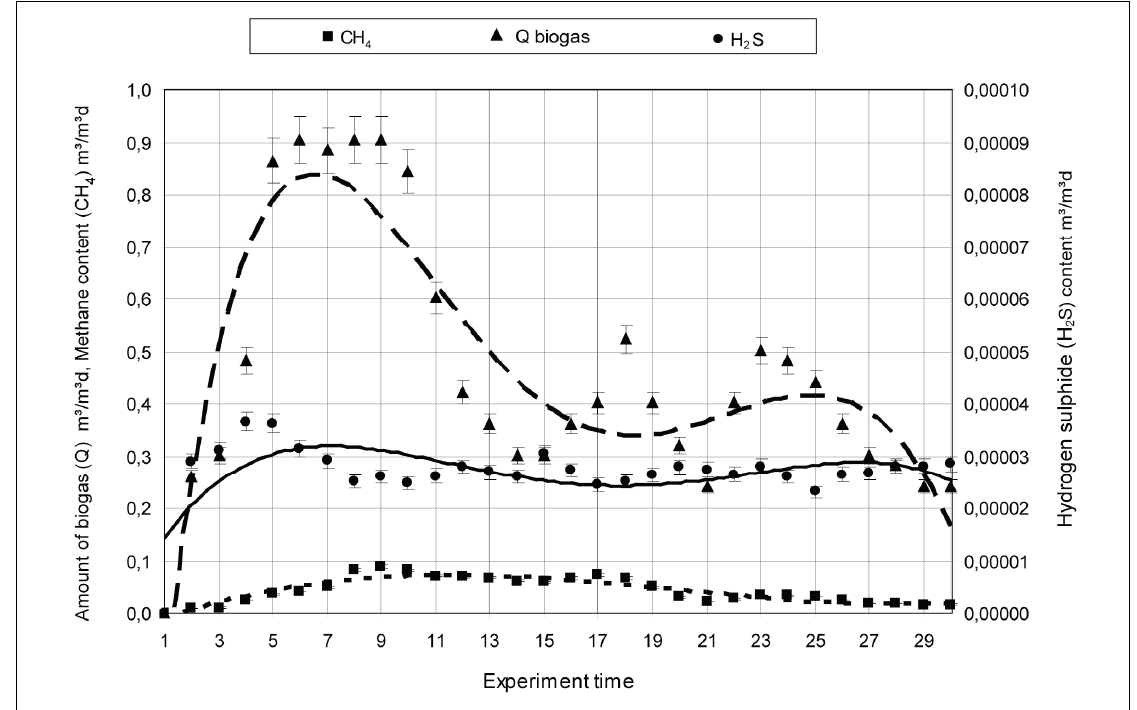
3 3 /m d), methane (m